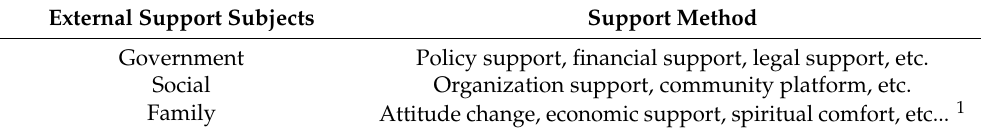
Table 1. Analytical framework of external support for elderly care-based social enterprises: the “government-society-family”